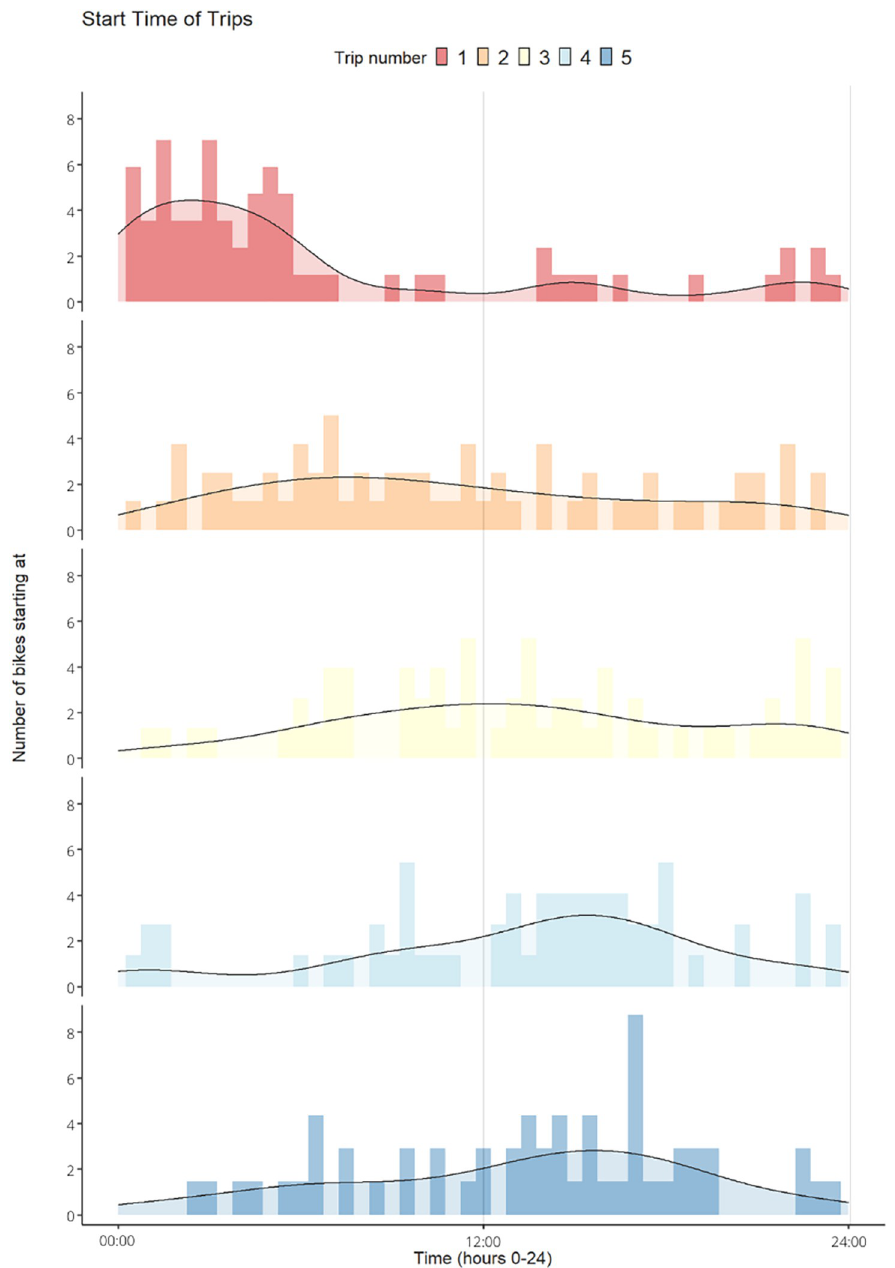
Fig 12. The number of bikes that started at the same time (could be a different date) for each of the first five trips the stolen bikes made. The start times of trip one are the times the bikes were stolen